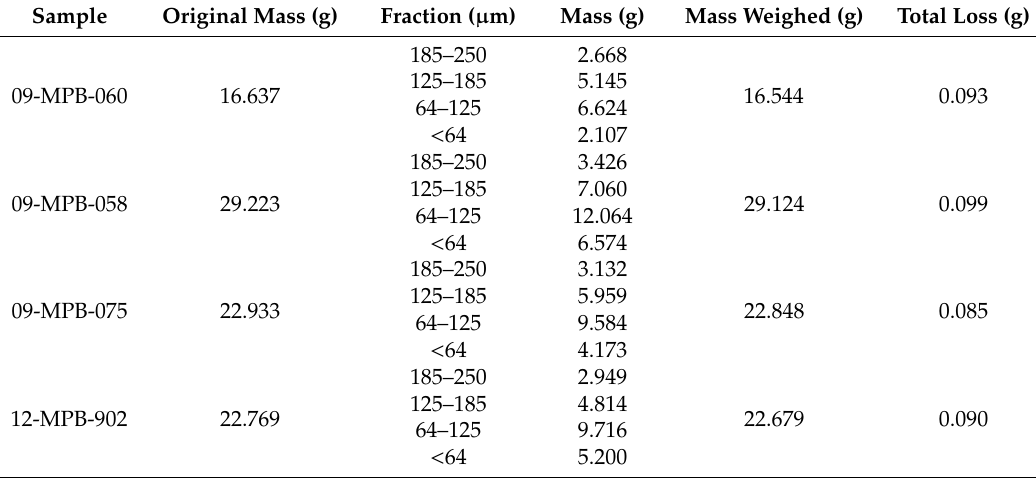
Table 1. Sample processing weights indicating the original mass of bulk till sample prior to heavy mineral concentrate (HMC) production, the individual mass of each size fraction following sieving of the < 250 µ m HMC, and the mass of < 250 µ m HMC lost during